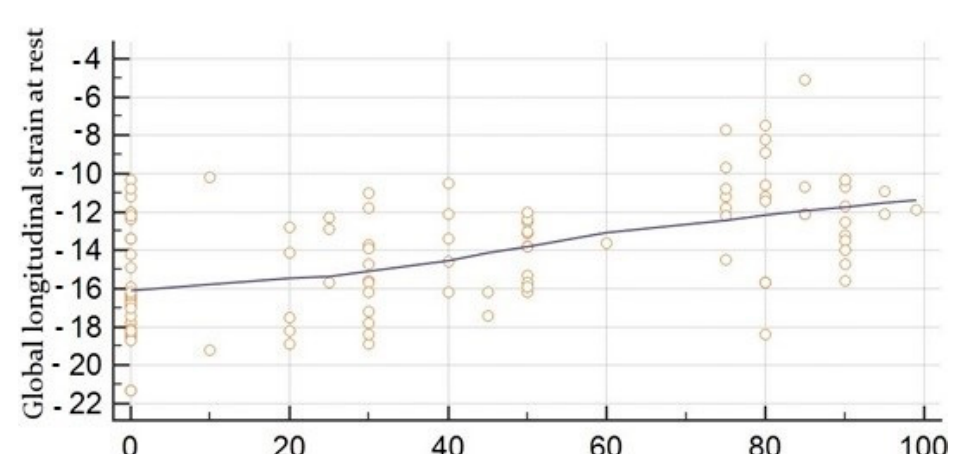
Figure 4. Correlation between global longitudinal strain under stress obtained by speckle tracking (in %) and the angiographic severity of coronary lesion (in %). A cuto ff value of − 19.1 (AUC: 0.754) led to a sensitivity of 74.1%, a speci fi city of 76.7% for detecting significant CAD, with a positive predictive value of 56.1% and a negative predictive value of 88.06% (Figure 6, Table 2).